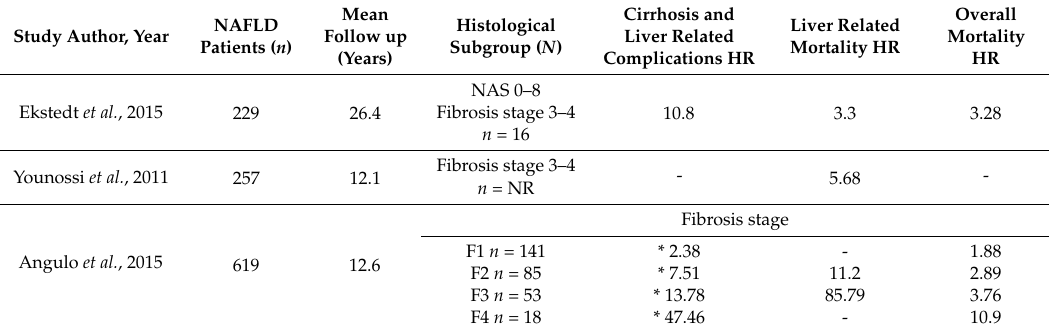
Table 2. Fibrosis stage as predictor of liver related complications, death, and overall